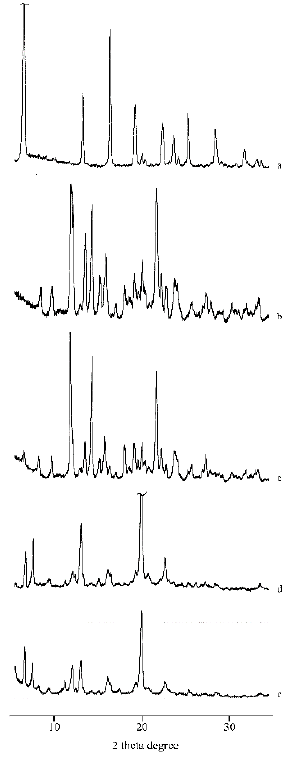
Figure 5. PXRD patterns of RSV ( a ), α -CD ( b ), their PM ( c ), MW ( d ), and CP ( e ) products.